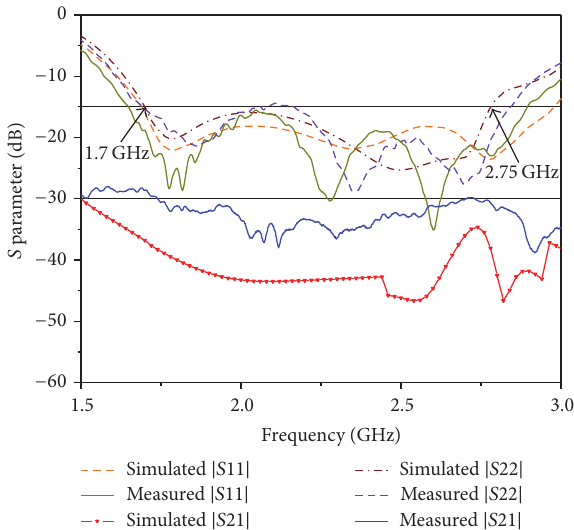
Figure 4: S parameters ( | S 11 | , | S 22 | , and | S 21 | ) simulated and measured for the V/H dual-polarized antenna.